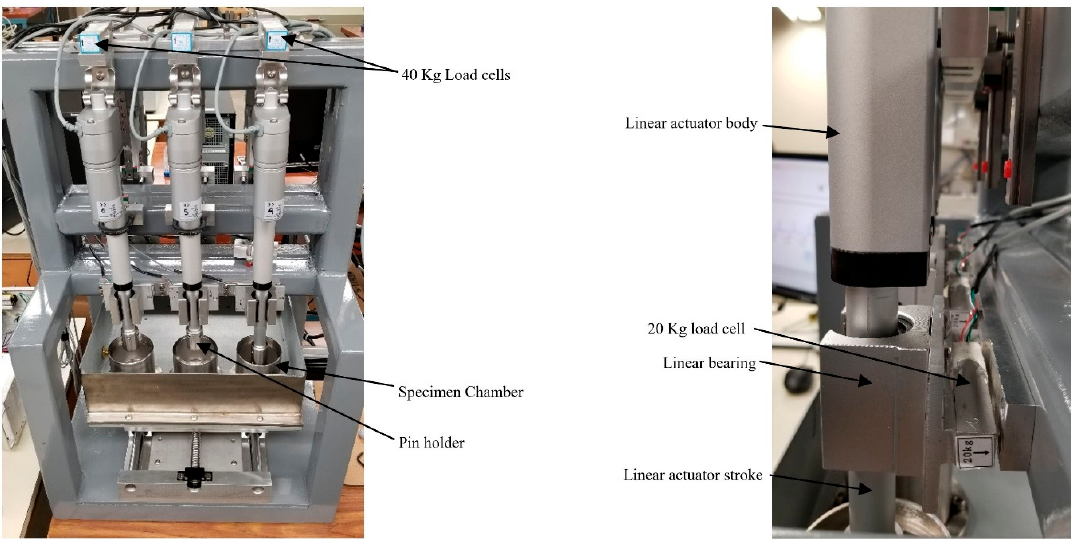
Figure 6. CNC-POD showing three testing stations.